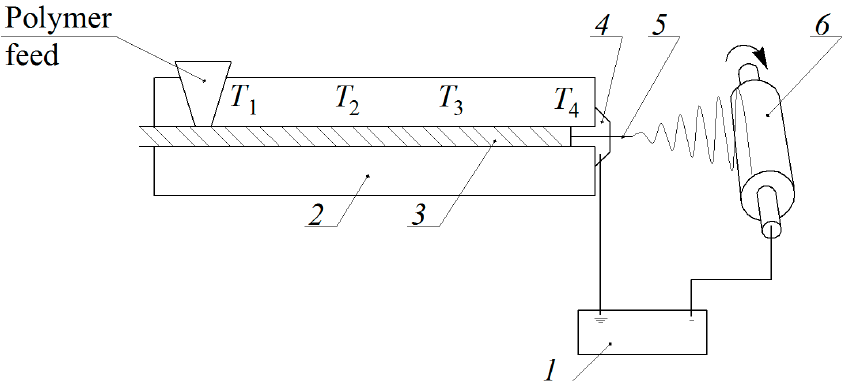
Figure 1. Experimental setup for melt electrospinning: 1—high voltage supply, 2—feeding device (extruder), 3—screw, 4—nozzle, 5—fiber, 6—collecting device.